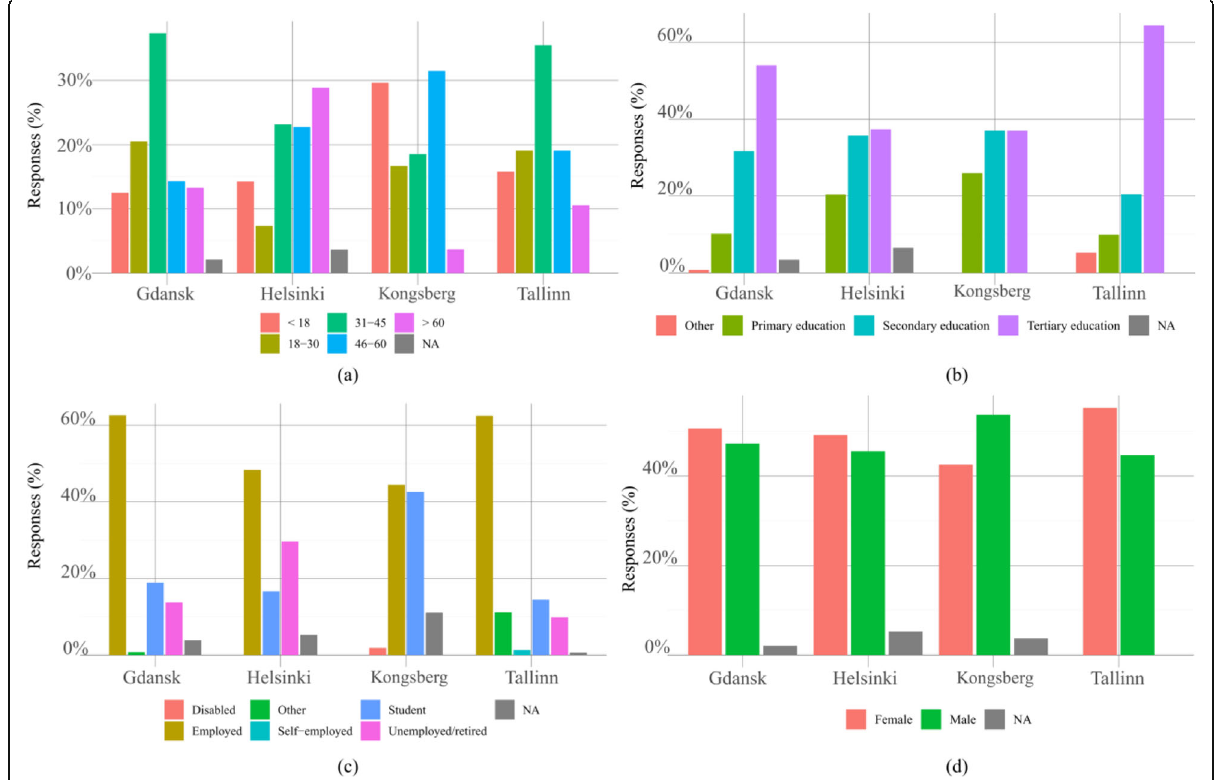
Fig. 1 General information about the respondents: ( a ) age group, ( b ) education, ( c ) employment, and ( d ) gender